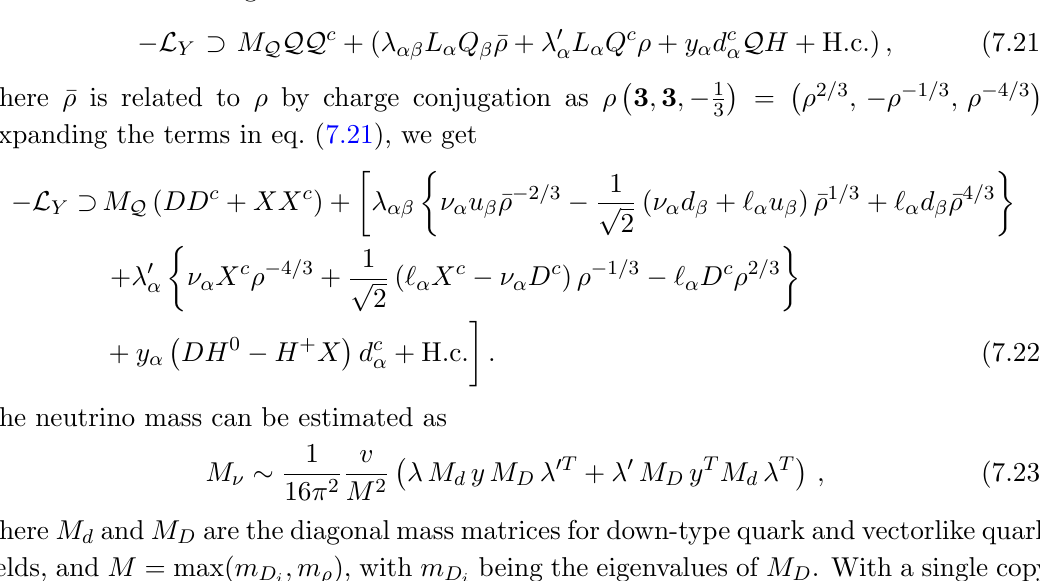
5 of table 3 3 O